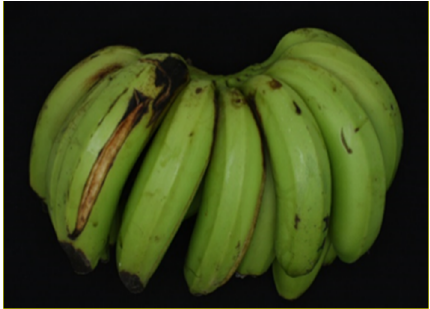
Figure 2. Sunburn (SB) symptoms from field heat injury.